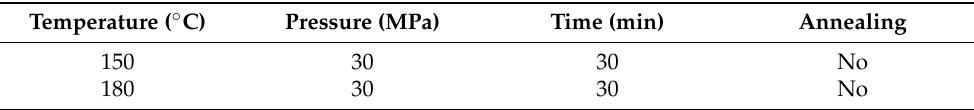
Table 1. Chip bonding